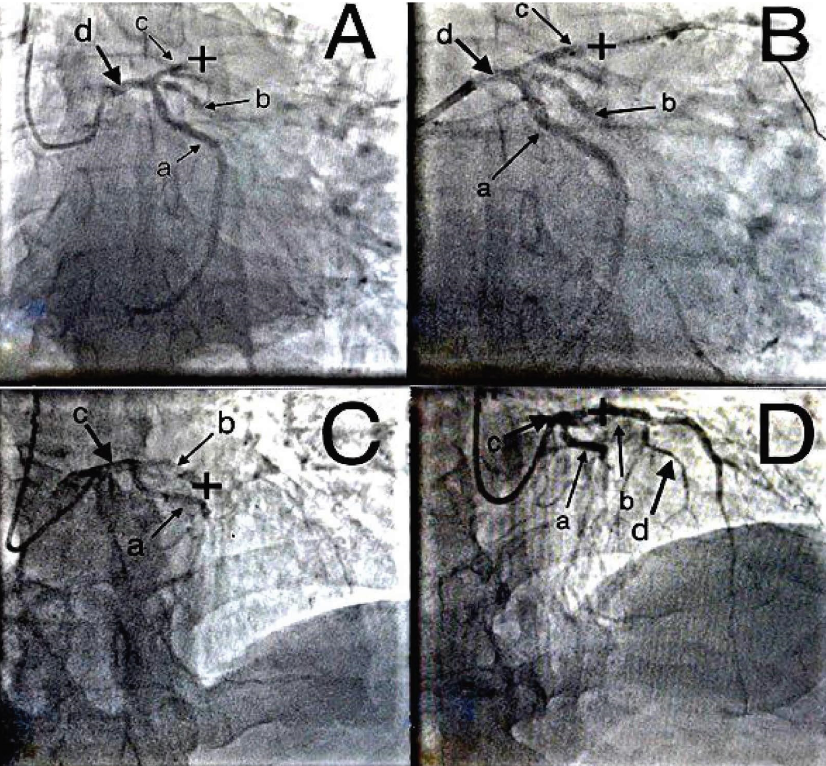
Figure 1: Two cases of acute coronary stent thrombosis. Case 3: (a) before intervention: a-LCx, b-arteria intermedia, c-LAD, d-left coronary artery, «+»-stent thrombosis; (b) after intervention: «+»-implanted stent. Case 6: (c) before intervention: a-LCx, b-LAD, s -left coronary artery, «+»-stent thrombosis; (d) after intervention: «+»-implanted